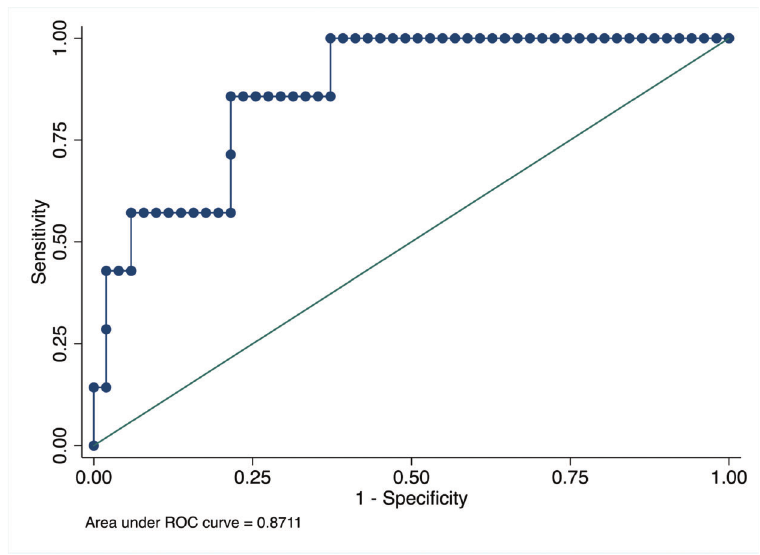
Figure 1 - Receiver operating characteristic (ROC) curve of the ability of the multivariate model to predict the occurrence of acute cellular rejection.